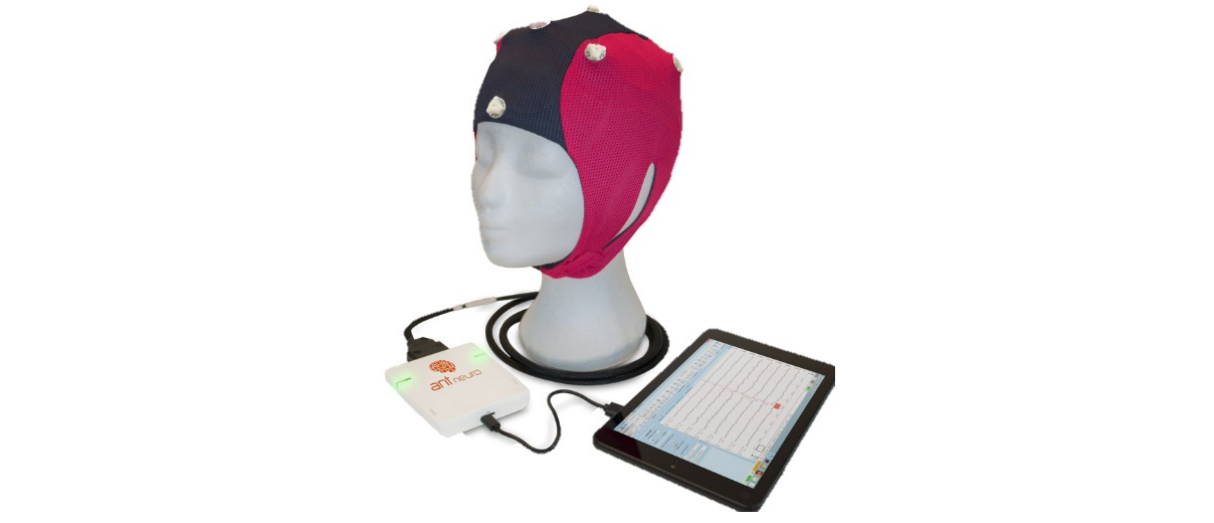
Figure 2. The ANT Neuro eego mini-series and ANT Neuro waveguard